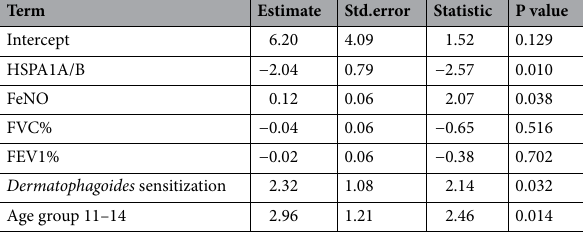
Table 1. Logistic regression model coefficients.